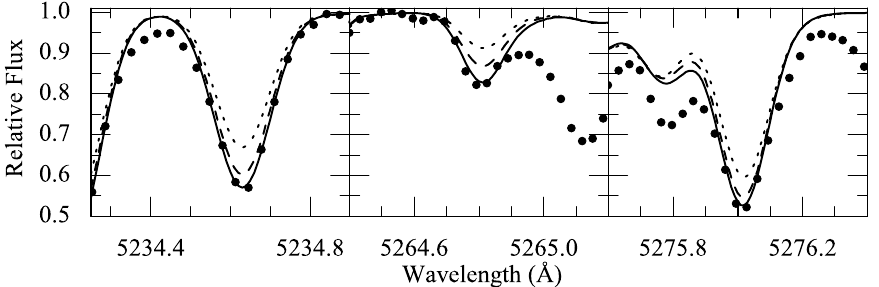
Fig. 4. Three Fe II lines in the spectrum of HD 209621 indicated by dots. The synthetic spectra shown are calculated using the final temperature and the iron abundance log ϵ (Fe) = 5.59 for the three gravities: log g = 1 . 0 (solid line), log g = 1 . 5 (dashed line) and log g = 2 . 0 (dotted line). known relation log g = 4 log T eff + log M/M ⊙ + 0 . 4 M bol − 12 . 51, if the